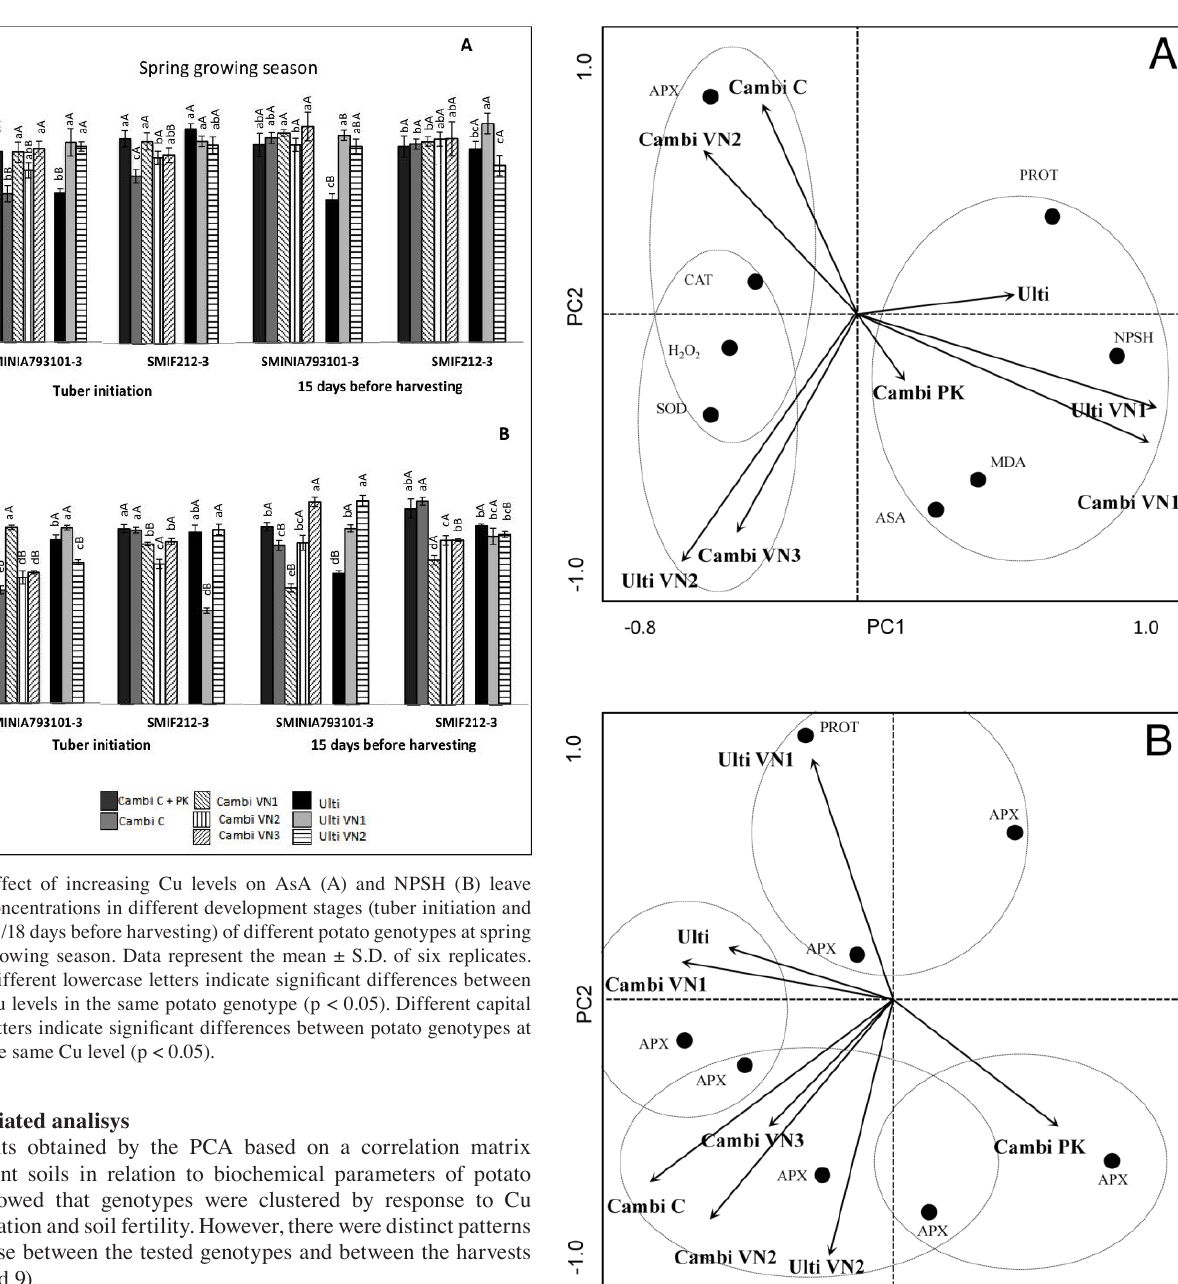
Fig. 8: Biplot graphic of scores and weights (loadings) for the first two principal components (PC1 and PC2) for biochemical parameters and tested soils at tuber initiation for SMINIA793101-3 (A) and SMIE (B) genotypes. MDA (lipid peroxidation); H2O2 (hydrogen peroxide concentration); SOD (Superoxide dismutase activity); CAT (catalase activity); APX (ascorbato peroxidase activity); PROT (protein concentration); AsA (ascorbic acid concentration); NPSH (non-protein thiol groups concentration). formation of four clusters in both harvests. For this genotype, MDA concentration, NPSH and SOD activity were the main parameters related to Cu toxicity and P deficiency at the first